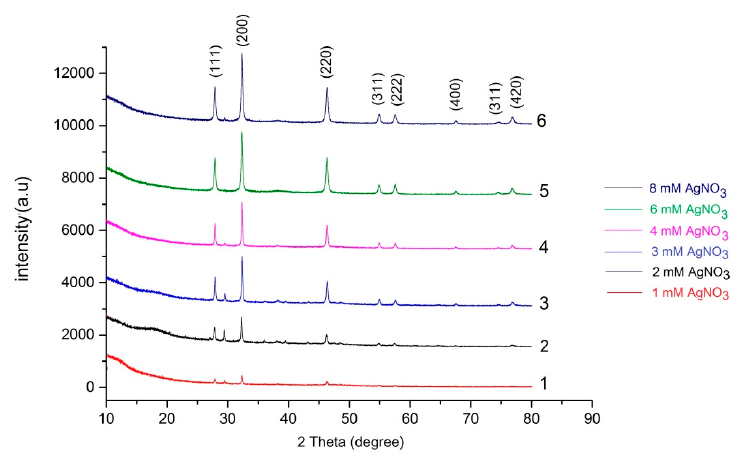
Figure 4. X-ray diffraction (XRD) pattern of AgCl-NPs, synthesized in different concentrations of AgNO 3 .